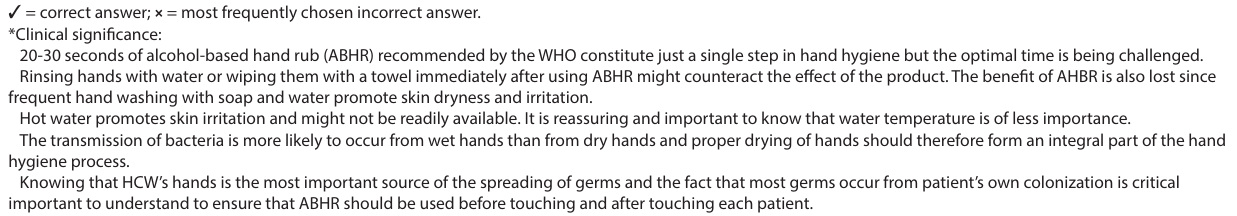
✓ = correct answer; ⨯ = most frequently chosen incorrect answer. *Clinical